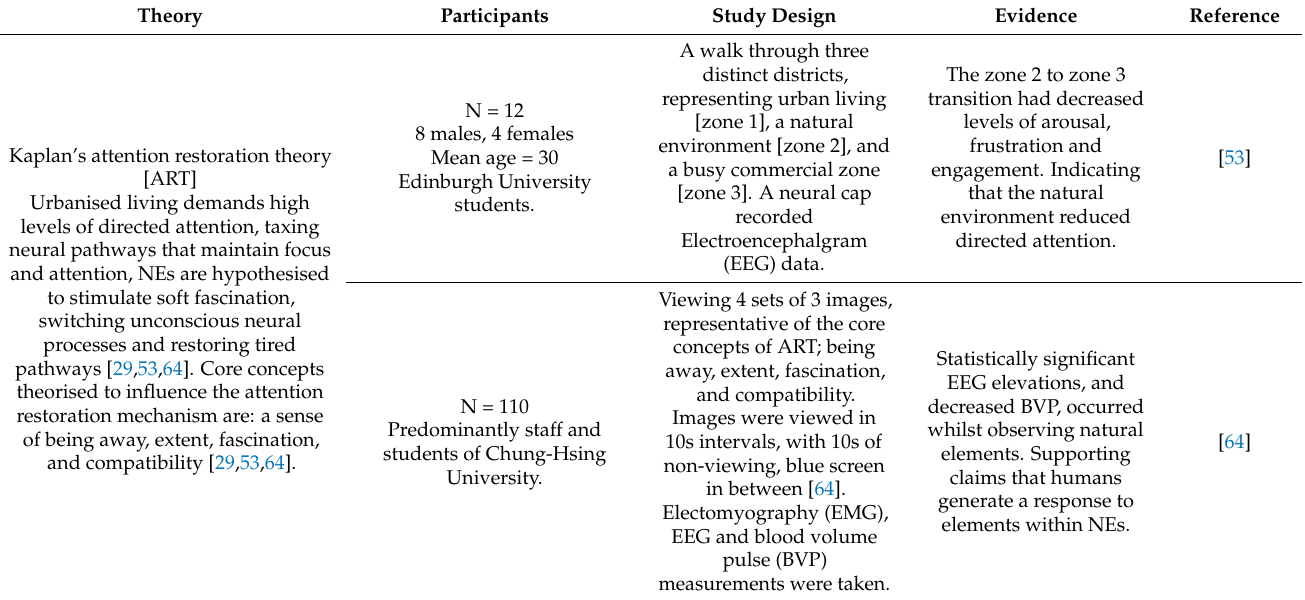
Figure 1. The complex relationships between Citizen Science, environmental exposure and human health. Evidenced and putative links are represented with arrows coloured in green (benefits), and red (harms). Abbreviations: ART: attention restoration theory IL-10: interleukin 10; SRT: stress reduction theory; TGF- β: transforming growth factor-beta. Table 1. Theories linking natural environments and human health, with details of key supportive experimental trials.